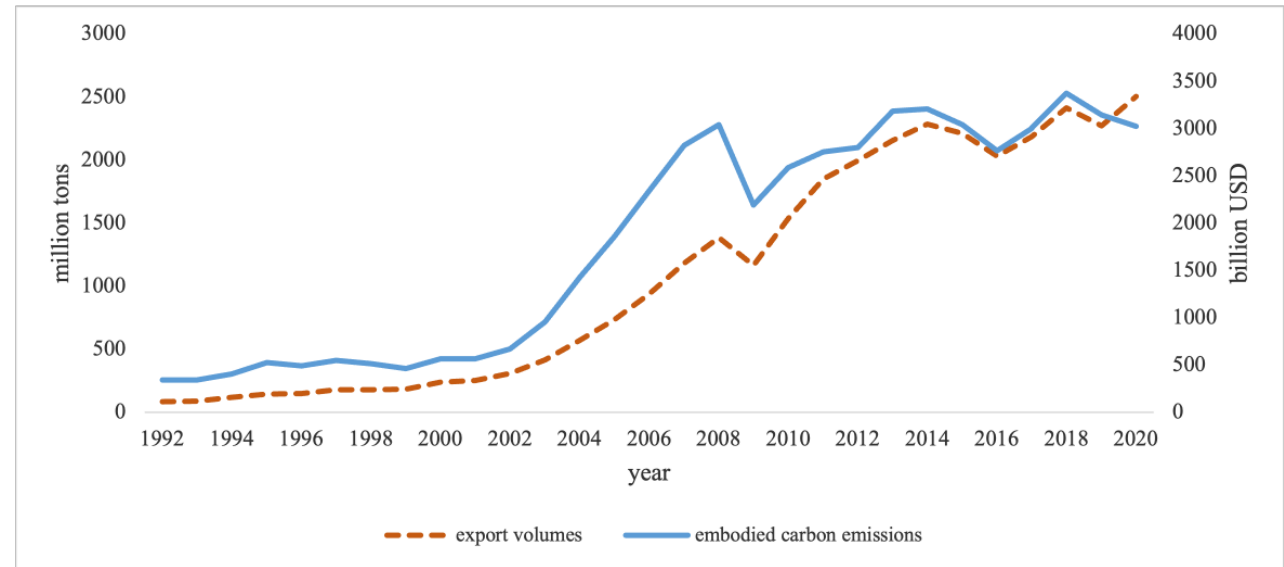
Figure 1. The trends of export volumes and the embodied carbon emissions for China from 1992 to 2020. Note: (1) The blue line, “export volumes”, stands for the total export volumes of China; (2) The red dotted line is the total embodied carbon emissions generated from the export.